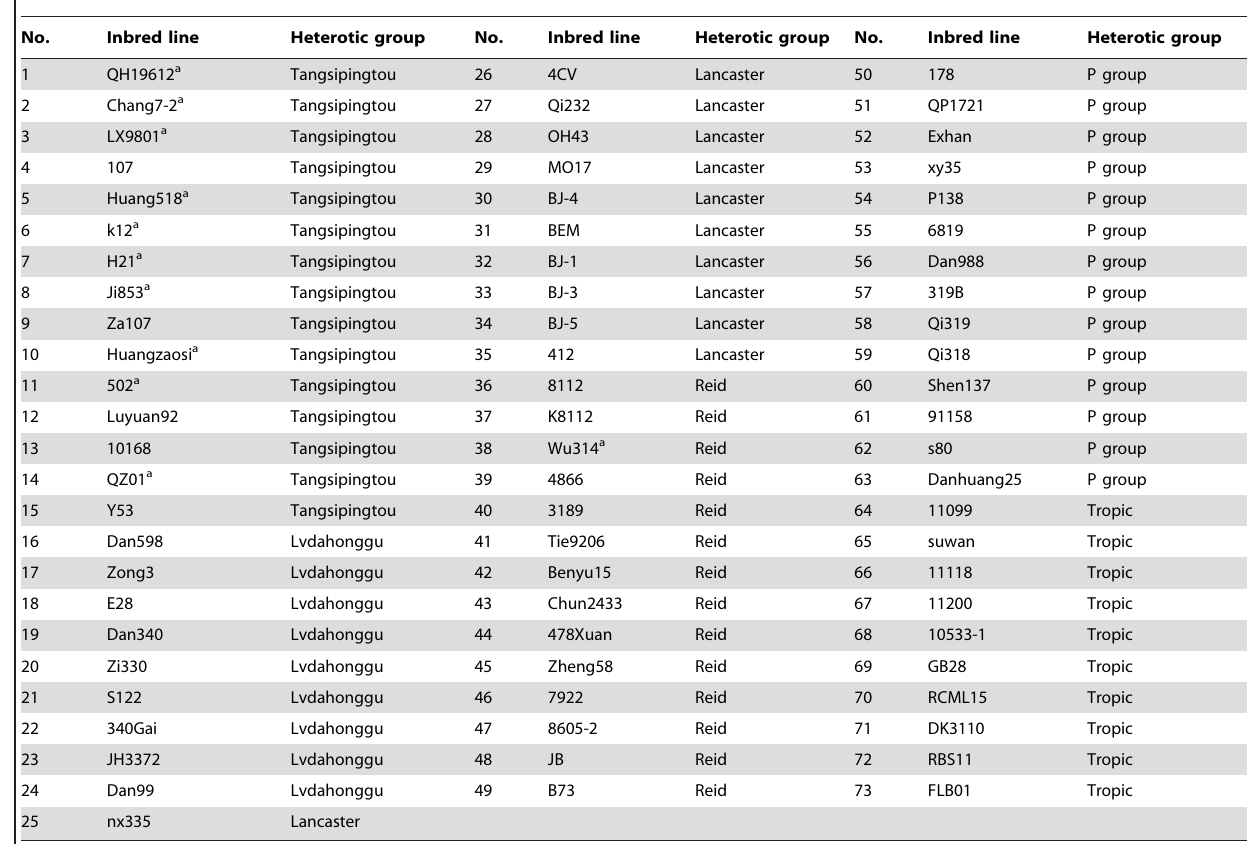
Table 1. List of the 73 inbred lines included in this